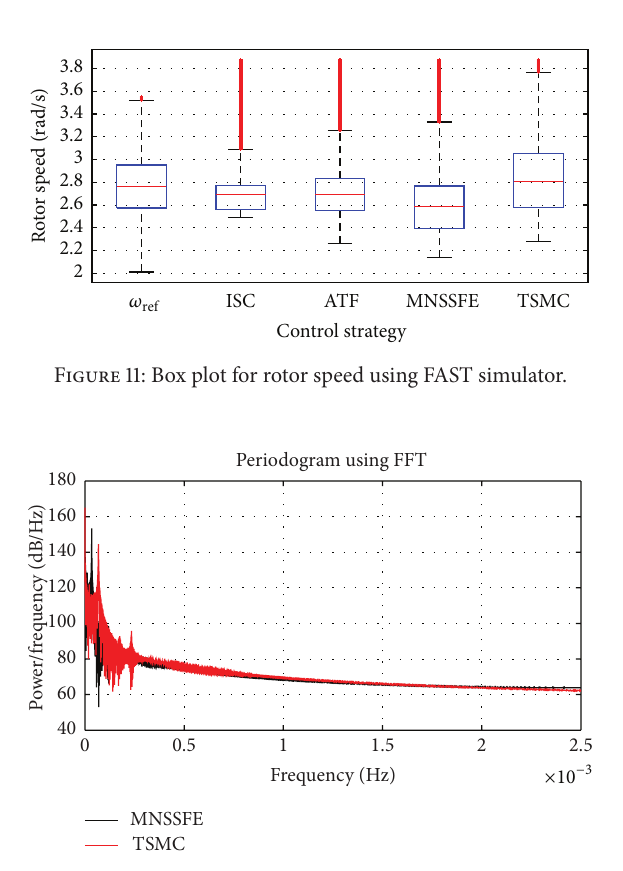
Figure 12: PSD for low speed shaft torque using FAST simulator.